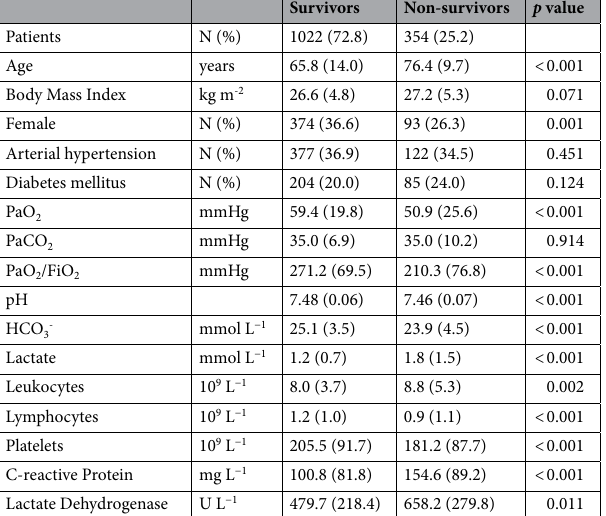
Table 2. Demographics, comorbidities, laboratory data and outcomes of survivors and nonsurvivors. Factor variables are expressed as count (%), continuous variables as mean (standard deviation) or as median (interquartile range). Fisher test was used for factorial variables and t-test and Mann–Whitney test for continuous ones. BMI, body mass index; PaO 2 partial pressure of arterial oxygen; PaCO 2 partial pressure of arterial carbon dioxide; PaO 2 /FiO 2 , partial pressure of arterial oxygen to the fraction of inspired